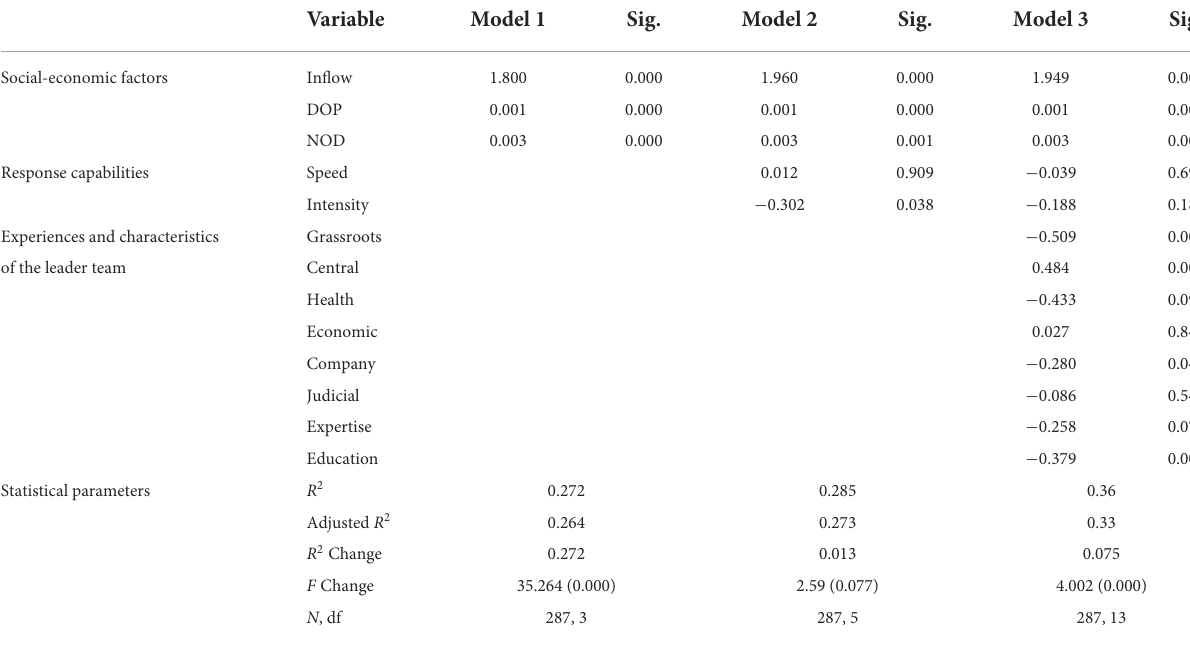
TABLE 2 Regression